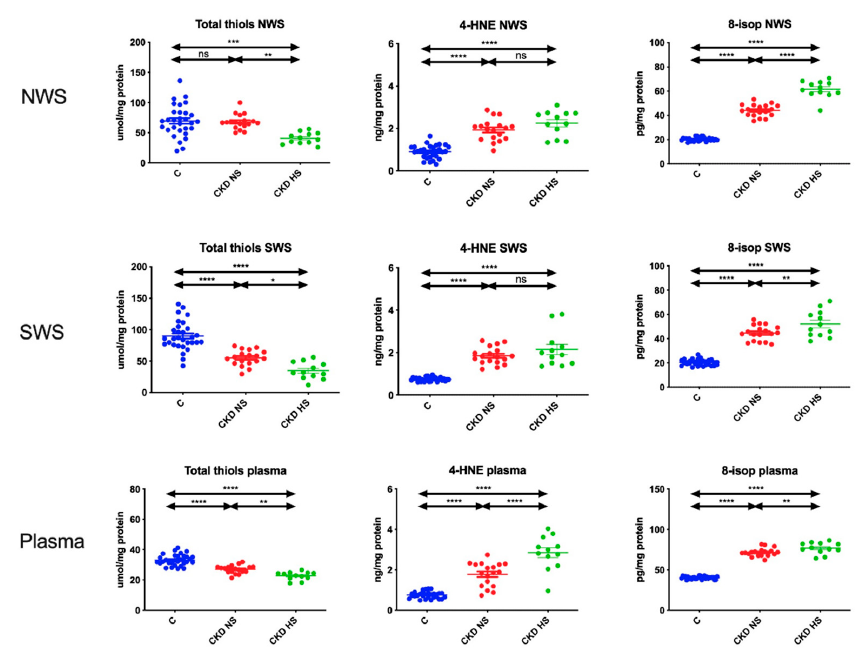
Figure 3. Oxidative damage to proteins and lipids in children with chronic kidney disease (CKD) and healthy controls. 4-HNE—4-hydroxynoneal protein adducts; 8-isop—8-isoprostanes; C—Healthy controls; CKD NS—CKD patients with normal salivary secretion; CKD HS—CKD patients with reduced salivary secretion; NWS—Non-stimulated whole saliva; SWS—Stimulated whole saliva. Di ff erences statistically significant at: * p < 0.05, ** p < 0.005, *** p < 0.0005, **** p <